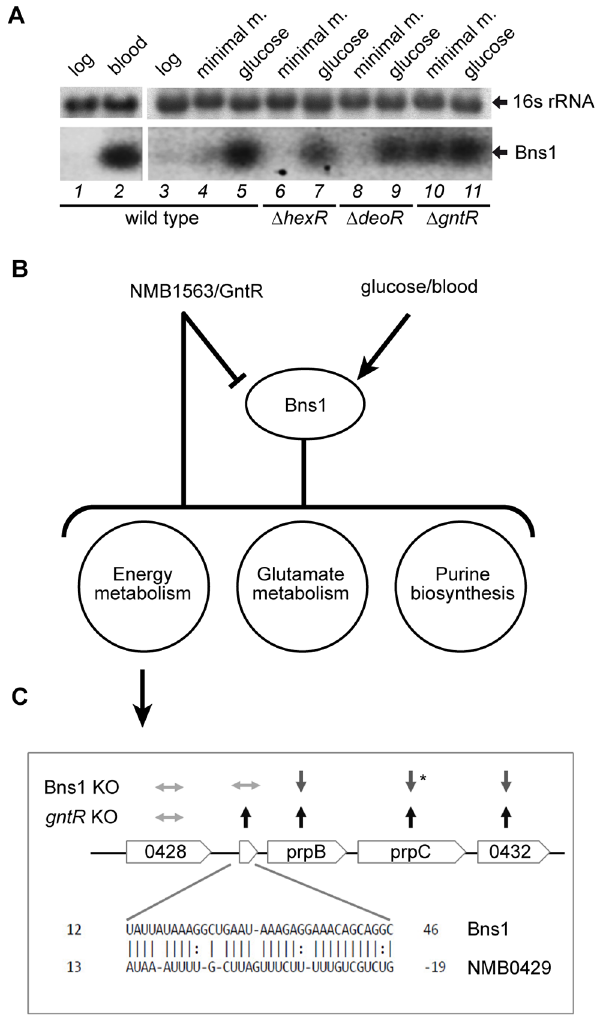
Fig 4. Bns1 regulatory network. (A) Northern blot experiments showing regulation of Bns in blood (left panel) and in minimal media (MM) or minimal media with 1%(w/v) glucose (gluc) in either wild type or indicated mutant strains (right panel). 16s rRNA is provided as a loading control. (B) Proposed model of Bns1 regulatory network (See text for details). (C) Bns1 target prediction on NMB429 and regulation of the operon NMB429-NMB432 in Bns1 and gntR KO strains. Asterisk indicates a p-value = 0.052 for the down-regulation of prpC in Bns1